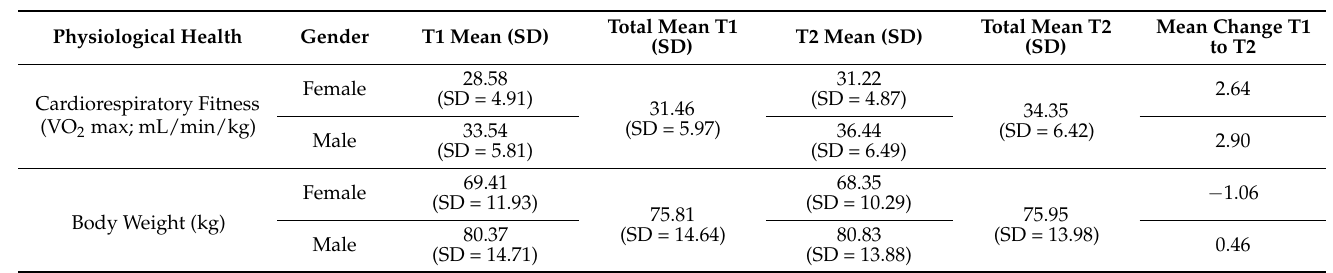
Table 2. Physiological health measures at week 0 (T1) and week 10